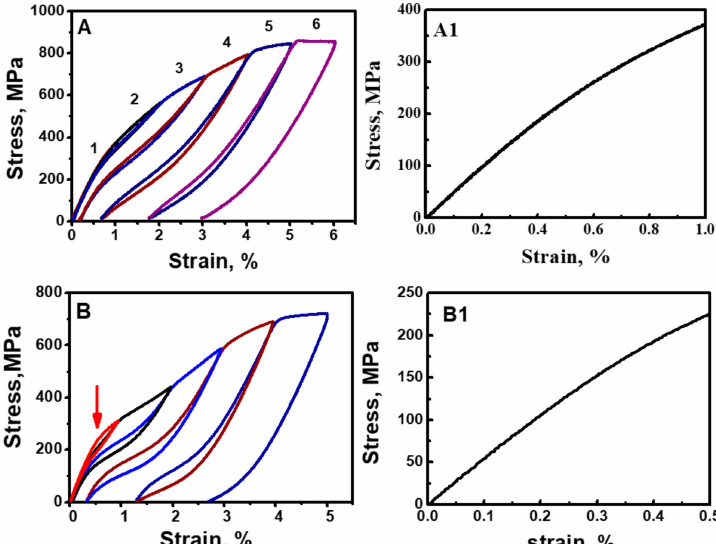
Figure 4. Nonlinear elasticity and elastic gradient. ( A , B ) Cyclic tensile loading and unloading stress–strain curves of the Ti-10V-2Fe-3Al-0.11O alloy and the Ti-10V-2Fe-3Al-0.82O alloy, in which the number on the curve represents the cycle number and the arrow shows the critical stress to induce martensite transformation (MT). ( A1 , B1 ) Enlarged stress–strain curves in the low-strain range. The Ti-10V-2Fe-3Al-0.82O alloy passed through martensite transformations (MTs) as the strain reached ~0.5% (Figure 4B) exhibited more significant nonlinear elasticity (Figure 4(B1)) and elastic softening in the low-strain range than the Ti-10V-2Fe-3Al-0.11O alloy. The following